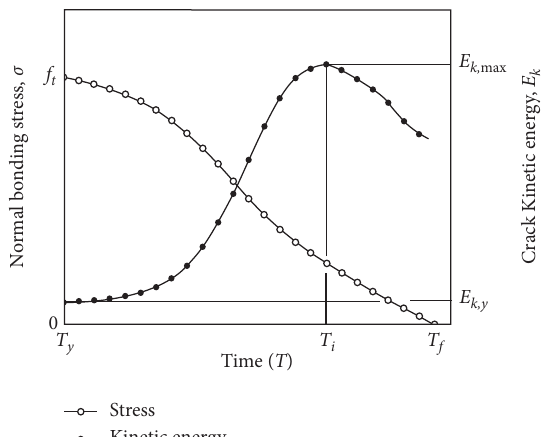
Figure 2: Schematic diagram of evolution of node repulsive force and mass kinetic energy for mode I failure [18].